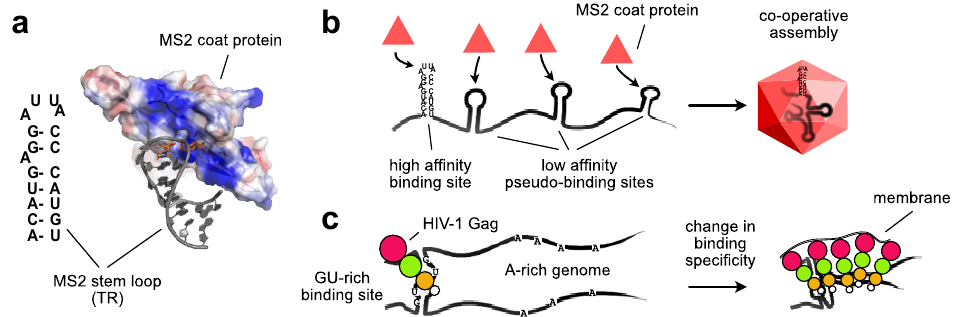
Figure 1. RNA packaging signals ( a ) MS2 bacteriophage encodes a coat protein (CP) that binds to a 19-nucleotide stem loop structure, known as TR. Secondary structure model of the TR stem loop and three-dimensional structure of the coat protein-TR interaction; (PDB: 1AQ3) ( b ) MS2 bacteriophage genome is encapsidated through cooperative interactions between coat protein that are bound to a high affinity binding site (TR) and multiple low affinity binding sites encoded throughout the genome; ( c ) HIV-1 Gag recognizes the genomic RNA through a GU-rich high affinity binding site in the 5′ untranslated region (5′UTR). During assembly at the plasma membrane Gag switches its specificity from GU-rich sequences to A-rich sequences, which is proposed to favour assembly of Gag on its cognate genomic RNA.